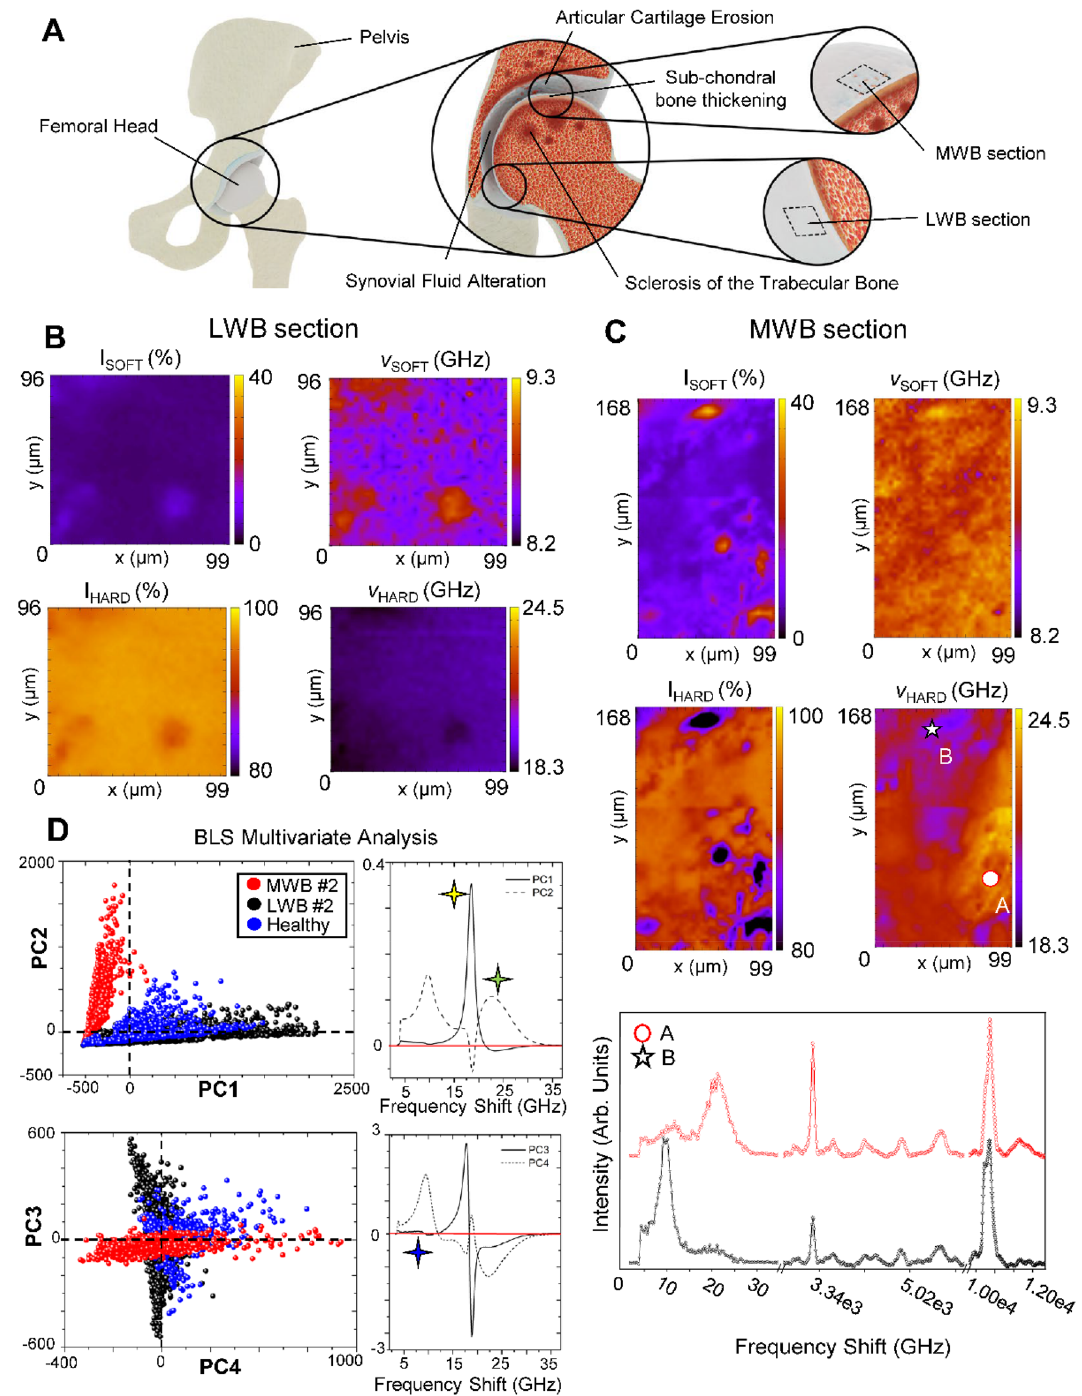
Figure 2. Mechanical imaging of the articular cartilage surface of the least weight-bearing (LWB) and most weight- bearing (MWB) sections of biopsy#2, revealing the main differences in their elastic properties. ( A ) Graphical sketch depicting the hip joint structure with a focus on the infero-medial (LWB) and supero-lateral (MWB) anatomical regions of the femoral head, along with the major manifestations of OA development on both the articular cartilage surface and the bone tissues. ( B ) Maps of the distributions of the relative percentage of P SOFT and P HARD components, namely I SOFT and I HARD , with their respective frequency shift ν SOFT and ν HARD in the articular cartilage surface of the section less subjected to mechanical stresses (LWB section). ( C ) On the top, maps of the distributions of the relative percentage of P SOFT and P HARD components, namely I SOFT and I HARD , with their respective frequency shift ν SOFT and ν HARD in the articular cartilage surface of the section subjected to major loads (MWB section). On the bottom, Brillouin and Raman single-point spectra (A-red circle and B-black star) collected in regions of interest on the map. ( D ) Brillouin spectral analysis by means of the principal component analysis (PCA), revealing the main differences among the spectra collected in the section subjected to the least weight-bearing (LWB #2—black), to the most weight- bearing (MWB #2—red) of sample#2, and the reference healthy phenotype